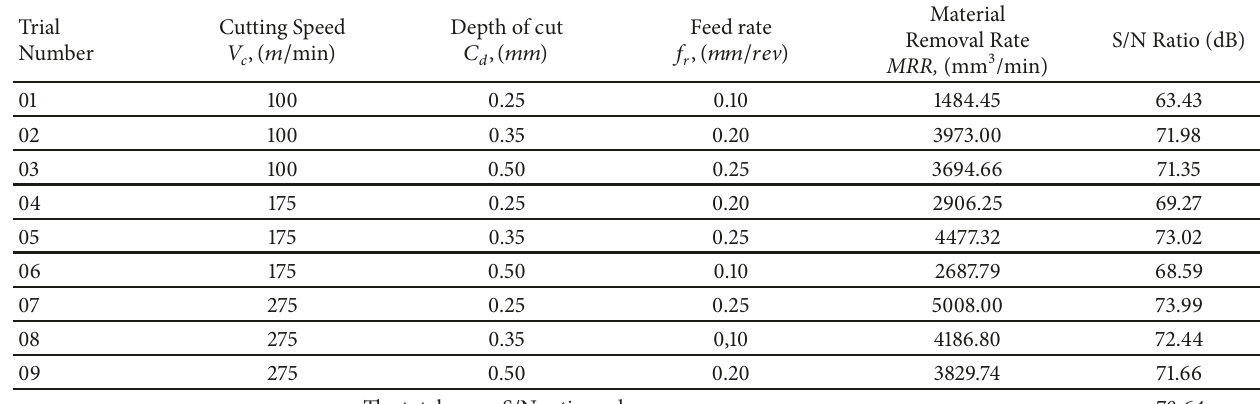
Table 5: Taguchi 𝐿 9 orthogonal array experimental design matrix results of performance parameters of material removal rate with the corresponding control factors.